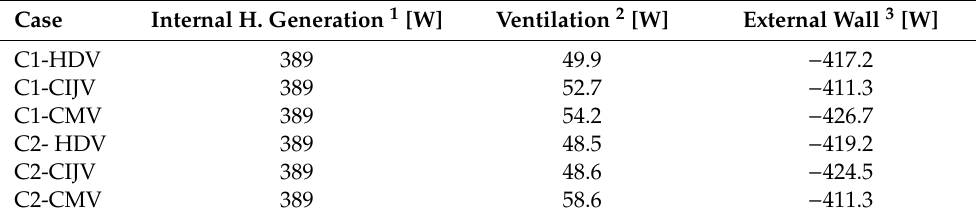
Table 2. Energy balance overview of the o ffi ce room.